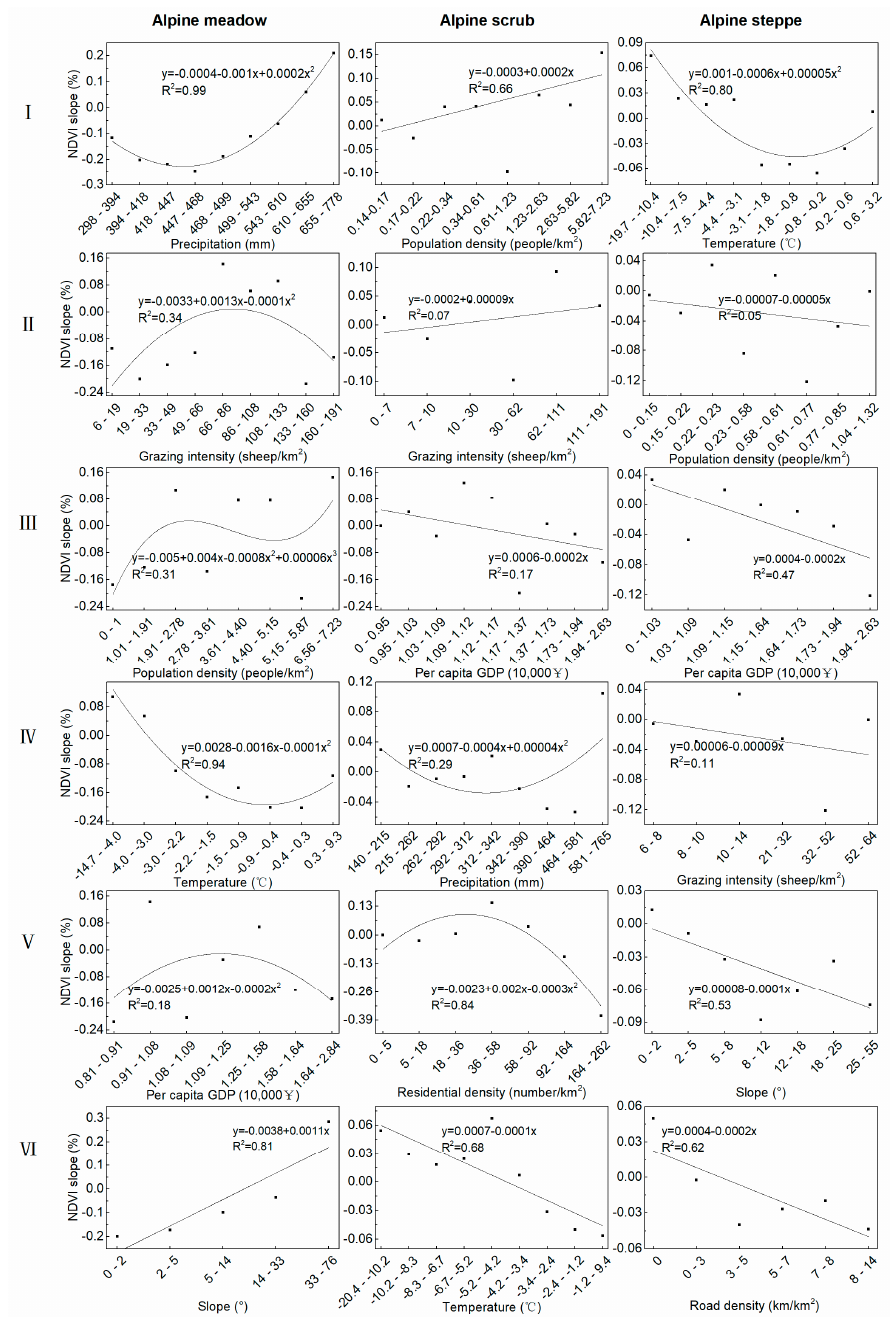
Figure 7. The relationship between mean NDVI slope and main driving factors. The horizontal axis of each subgraph denotes the subrange of di ff erent variables, while the vertical axis represents